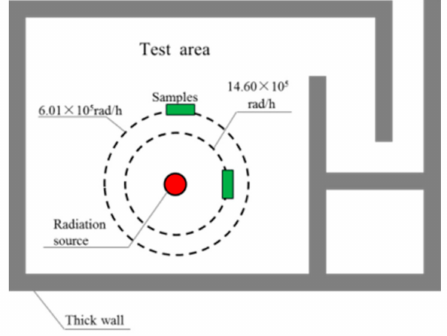
Figure 1. Irradiation chamber and specimen